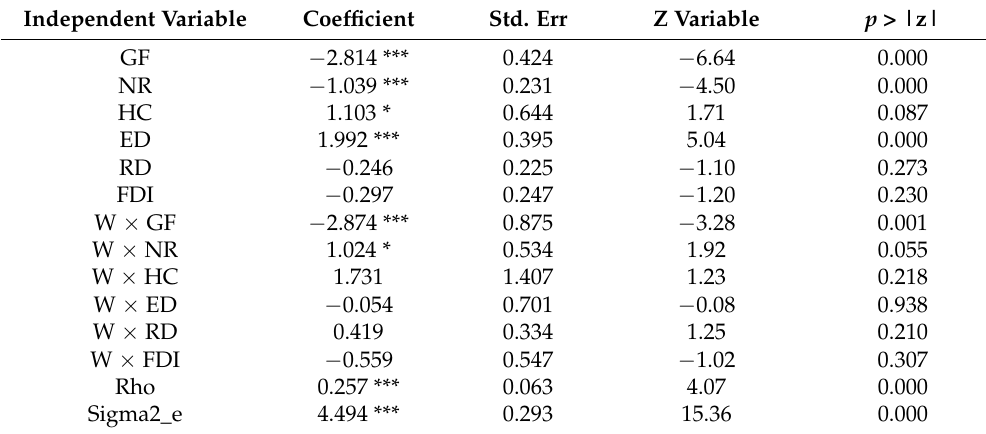
Table 4. Spatial Durbin model estimation and test results. Independent Variable